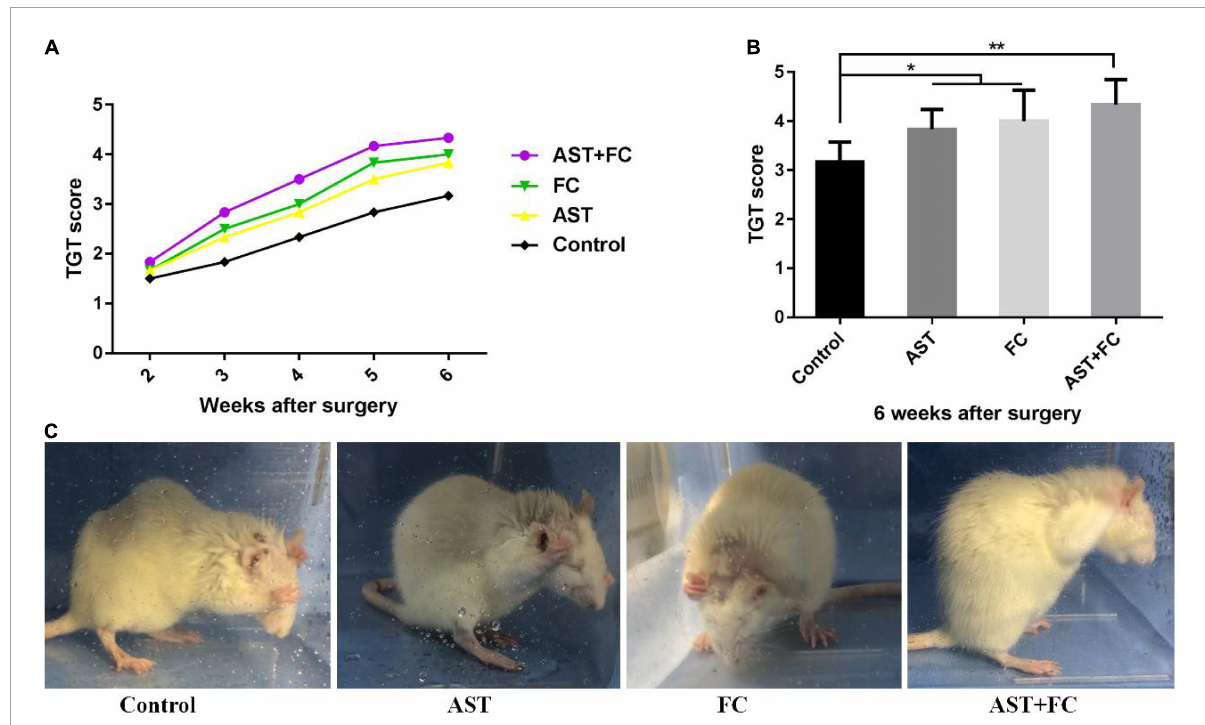
FIGURE3 The postsurgical motor function of the involved limbs in the control, AST, FC, and AST + FC groups. (A) Each week’s TGT scores during the 2nd to 6th week in control, AST, FC, and AST + FC groups after BPA ( n = 6); (B) average TGT scores in control, AST, FC, and AST + FC groups at the end of the 6th week after BPA ( n = 6, * p < 0.05, ** p < 0.01); (C) images of the gross motor function of the involved forelimb in control, AST, FC, and AST + FC groups at the 6th week after